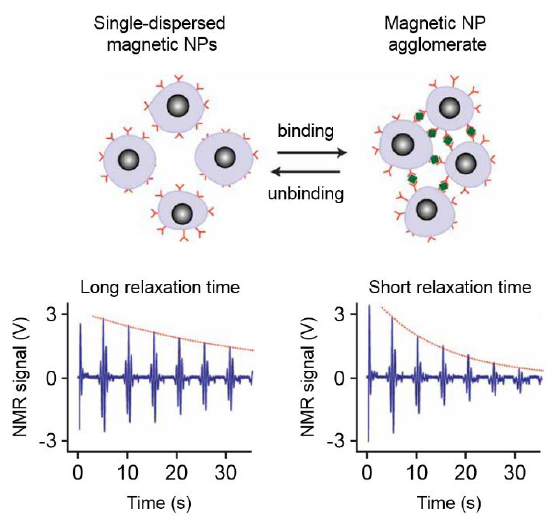
Figure 7. Schematic principle of the magnetic relaxation switch (MRSw) measurement method. Single-dispersed magnetic NPs can cross-link to form NP agglomerates, which results in a shortening of the transversal relaxation time T 2 . Vice versa , unbinding processes starting from particle agglomerates and resulting in single-dispersed NPs increase the measured relaxation time. While binding of NPs can be caused by the analyte of interest itself, unbinding may result from an addition of suitable enzymes, competitive binding processes or changes of the pH value and of the temperature. Raw signals of NMR measurements are shown at the bottom to illustrate the different relaxation times (indicated by the red dotted lines). Modified graph reprinted from Lee et al. , [191] by permission from Macmillan Publishers Ltd., copyright